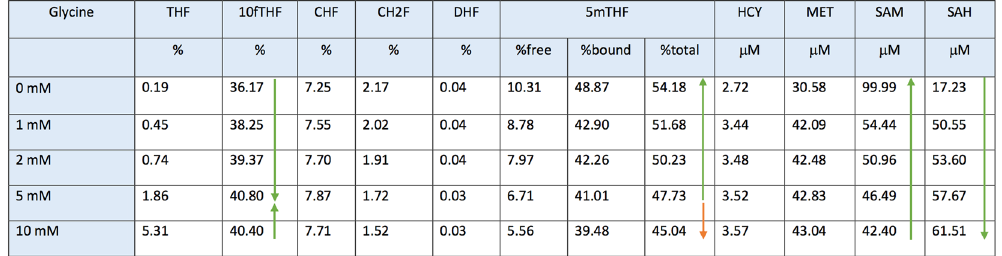
Figure 2. Steady states for five different values of glycine (folate cycle in % and the homocysteine remethylation cycle in μ M). Where possible, a trend arrow is provided on the right to show the experimental outcome observed in Herbig et al . 28 . All the trends are consistent with literature (green arrows) except for the total % of 5 mTHF in the glycine range 5–10 mM (red